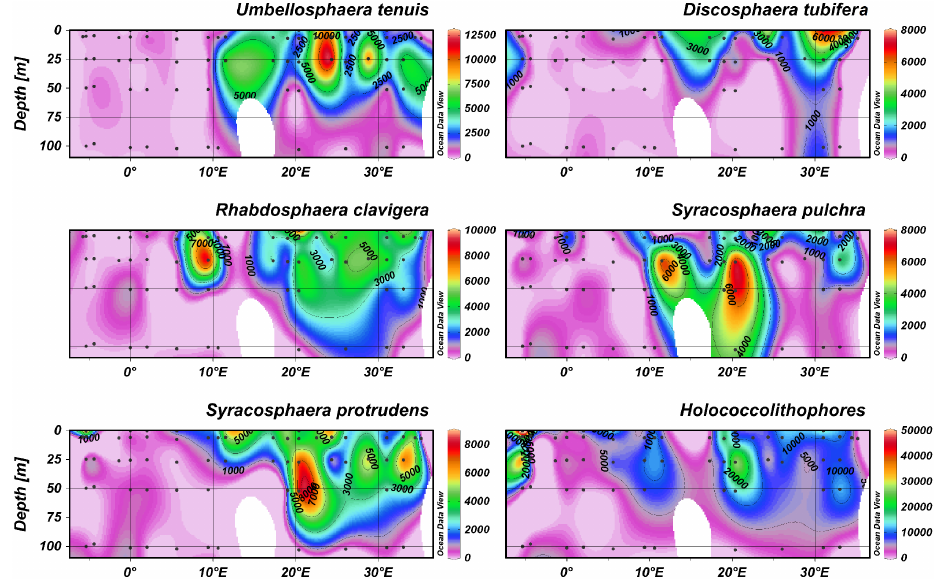
Figure 6. Distribution, along a west–east transect, of the heterococcolithophore species forming the cluster comprised mainly of “eastern Mediterranean species”. Holococcolithophores as a group are added in the bottom right panel (the transect includes the stations labeled in black in Fig. 1).